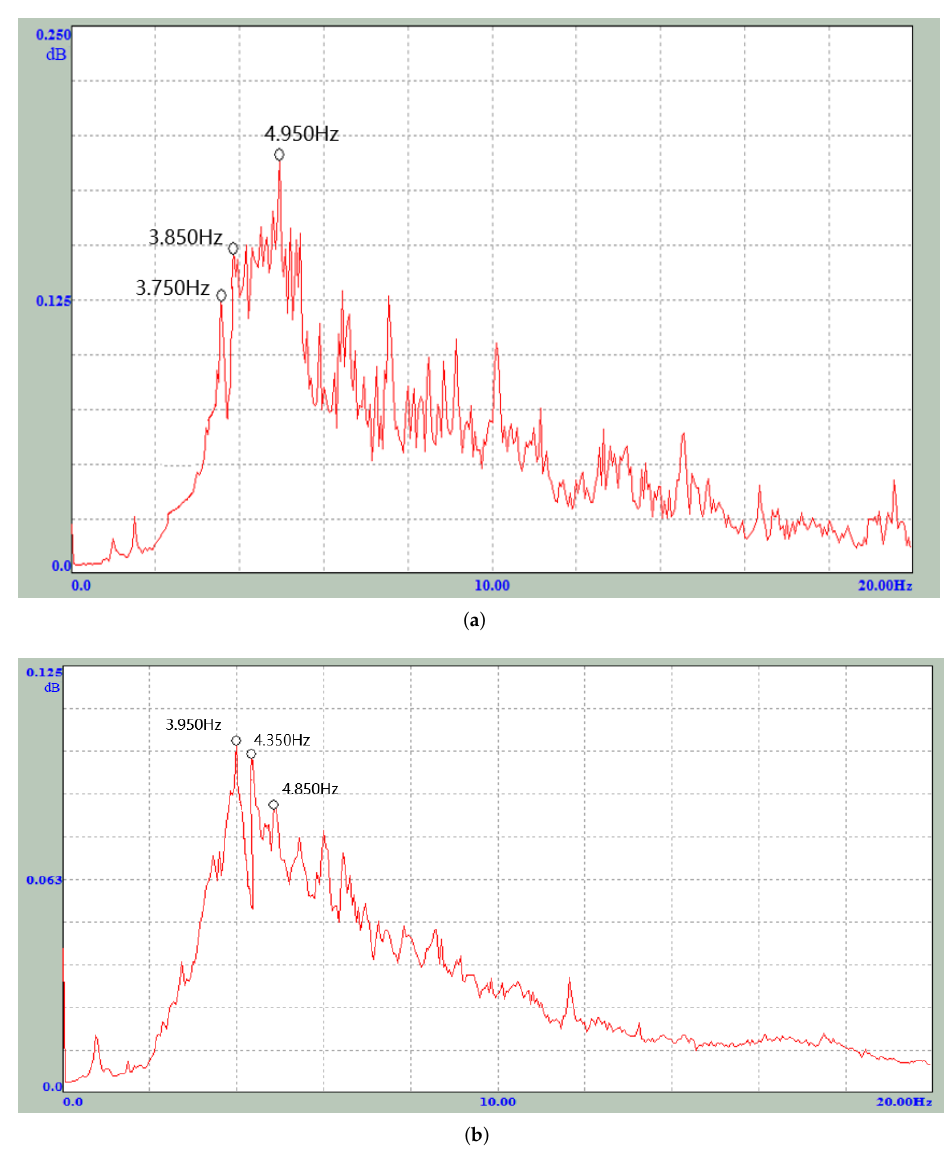
Figure 4. First-order vertical mode shape of ( a ) Area 1 and ( b ) Area 2.